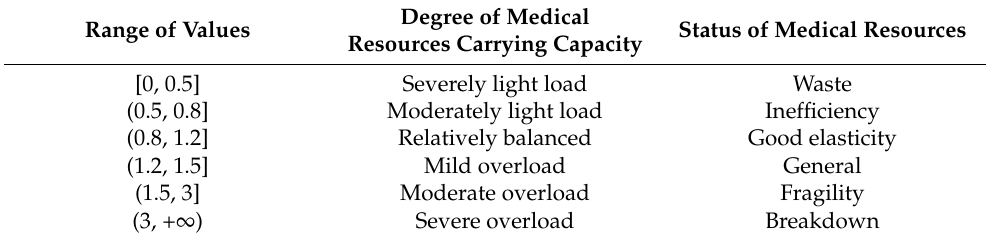
Table 2. Medical service carrying status.